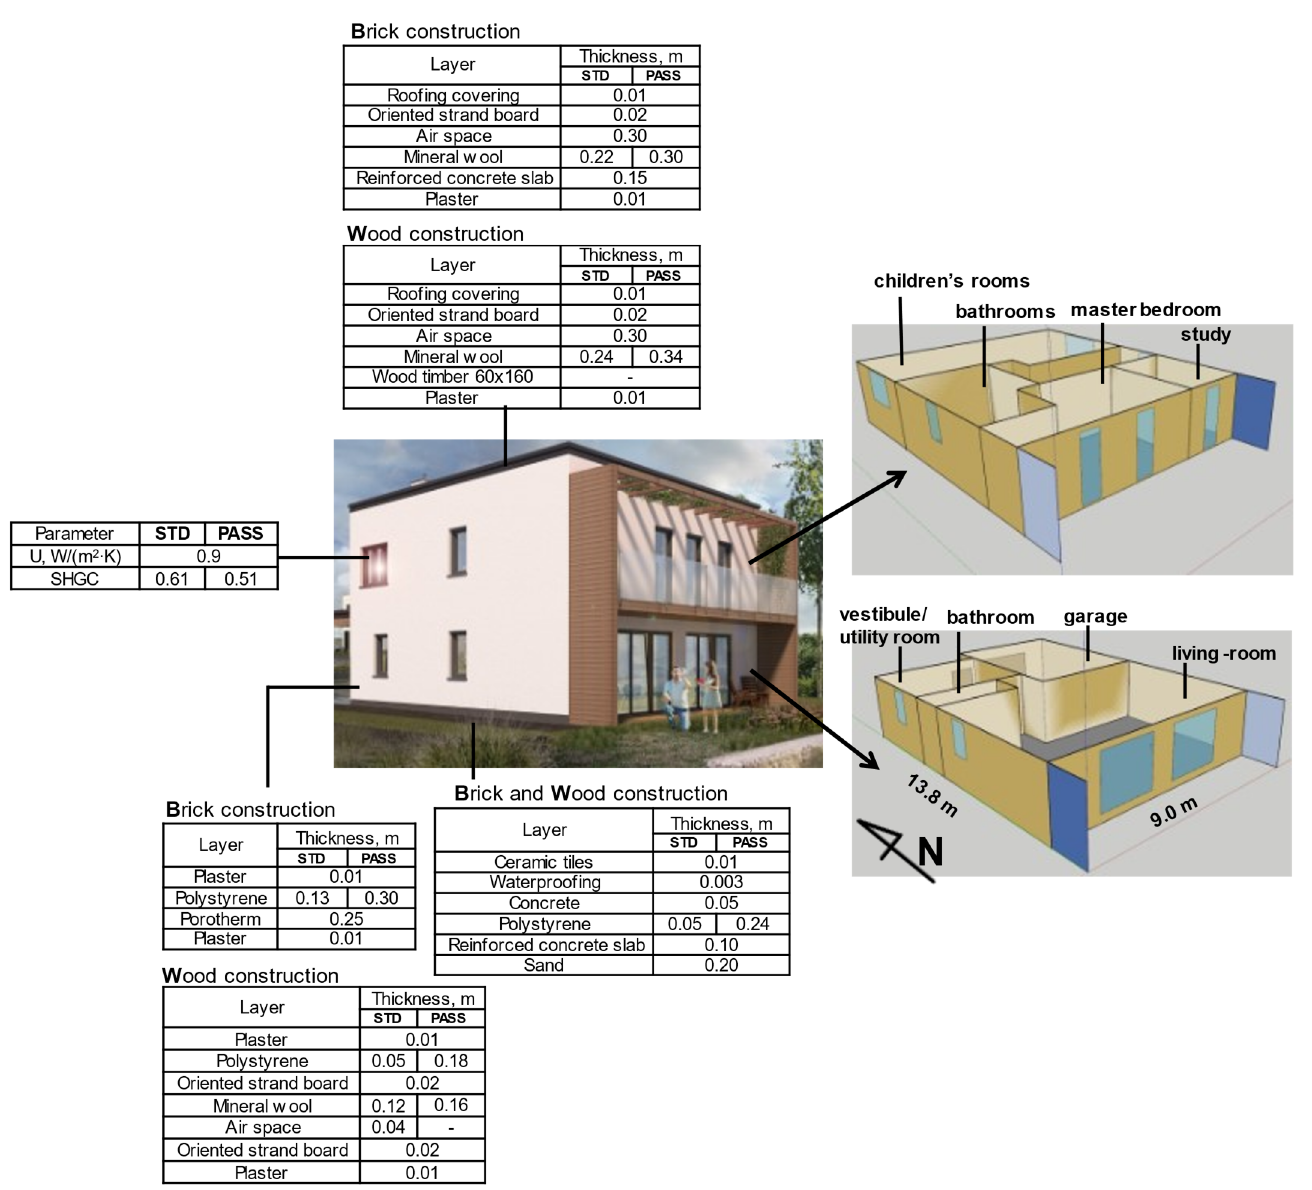
Figure 1. The building under consideration and construction details.